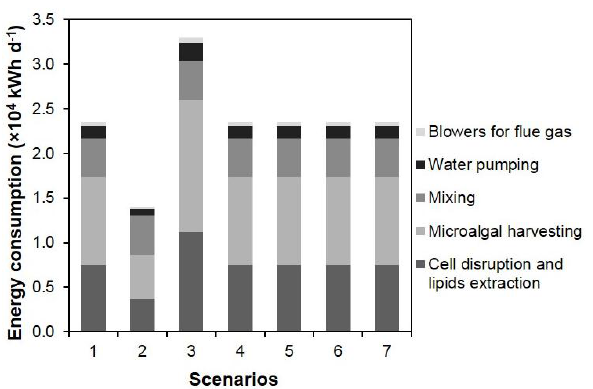
Figure 3. Electrical requirements determined for different steps of the microalgal facility in each of the studied scenarios.